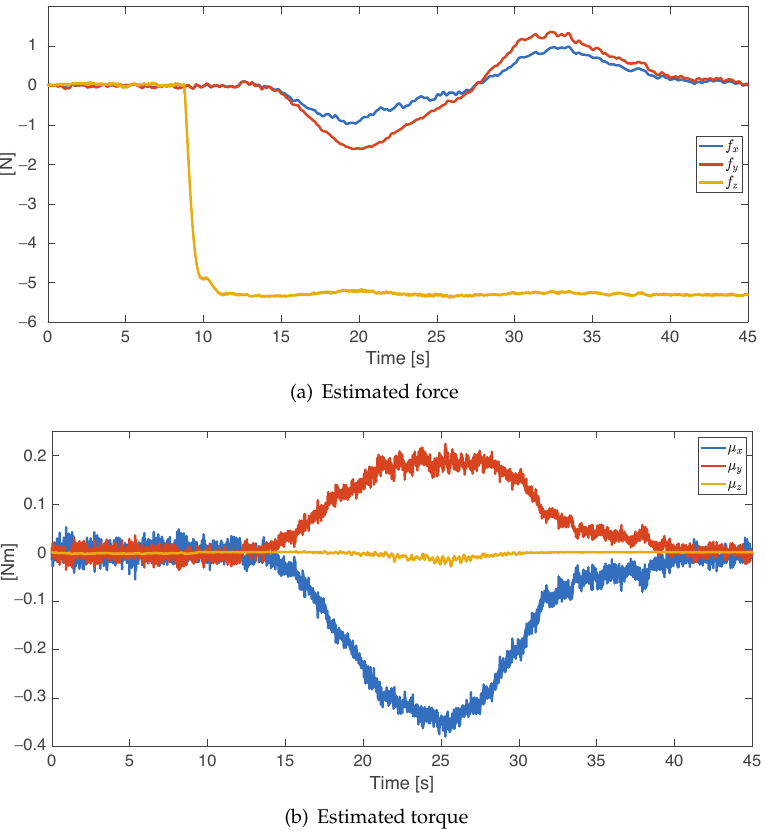
Figure 9. Second case study: estimated